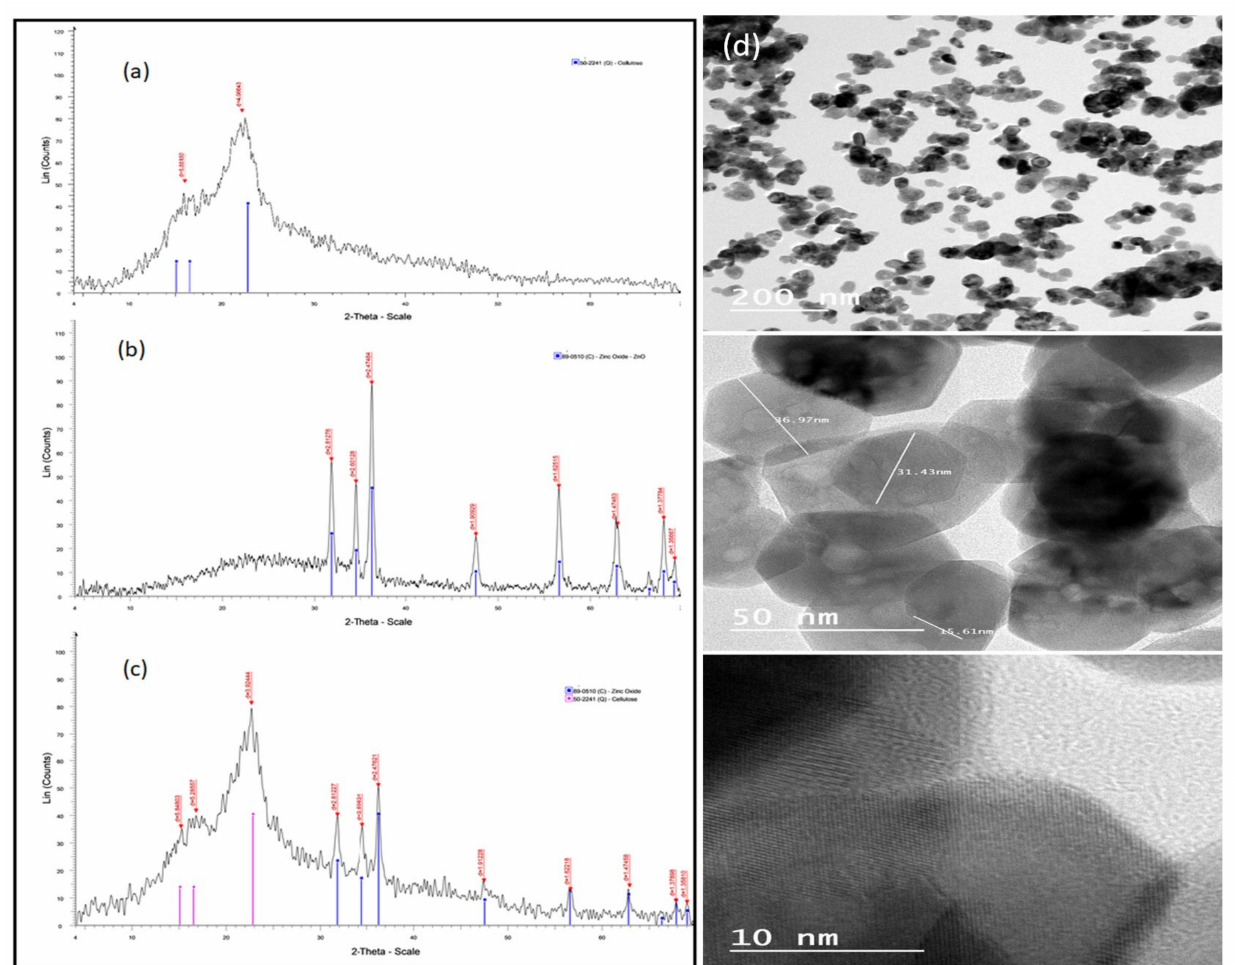
Figure 1. XRD patterns of the DPF sorbent ( a ), ZnO NPs ( b ), and the ZnO NP/DPF nanocomposite ( c ) and TEM images of ZnO NPs at different magnifications ( d